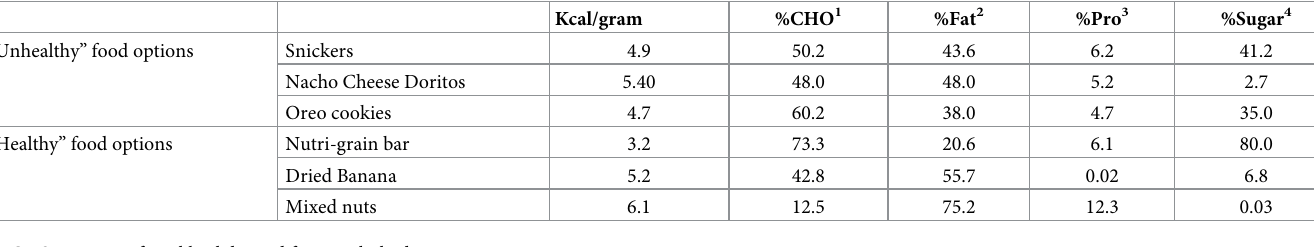
Table 1. Foods used in the progressive ratio schedules of reinforcement task to measure food